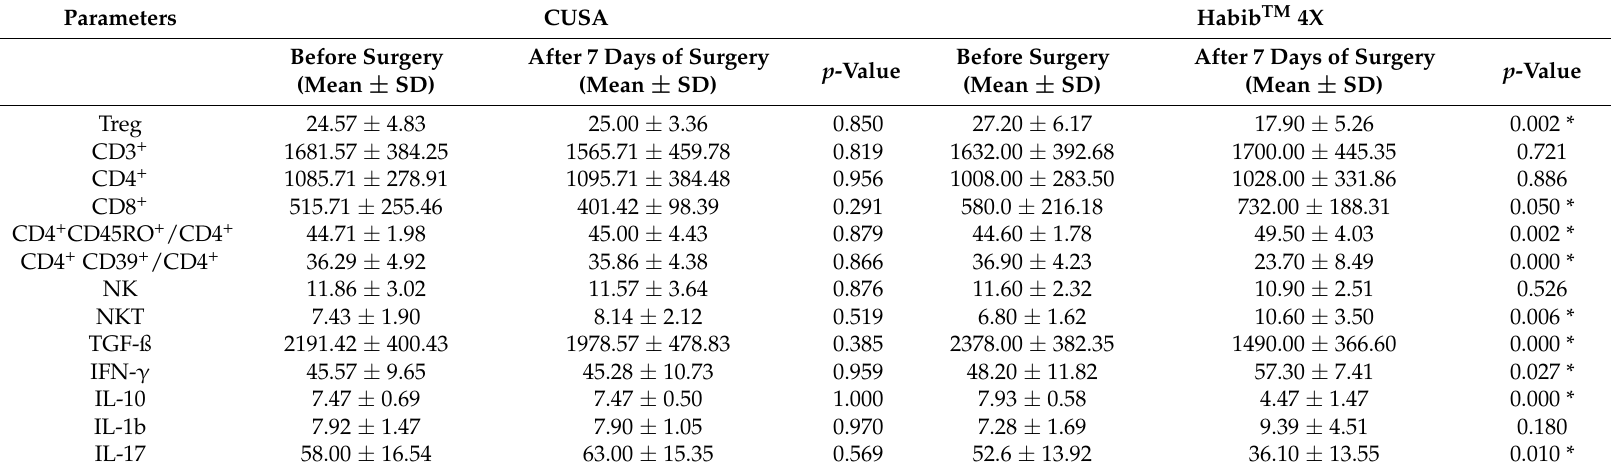
Table 3. Observed immunomodulatory changes in respective groups before and after